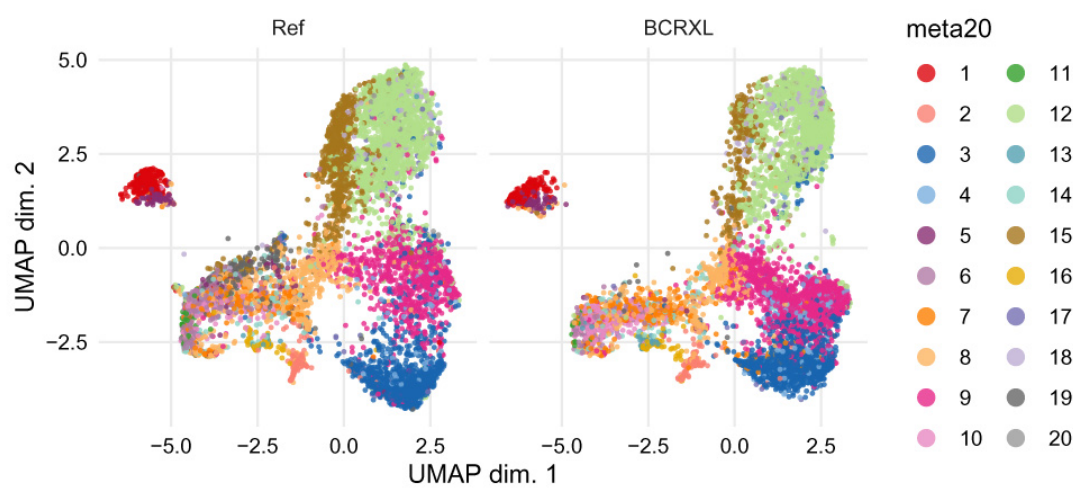
Figure 12. UMAP as in Figure 10, but stratified by condition.